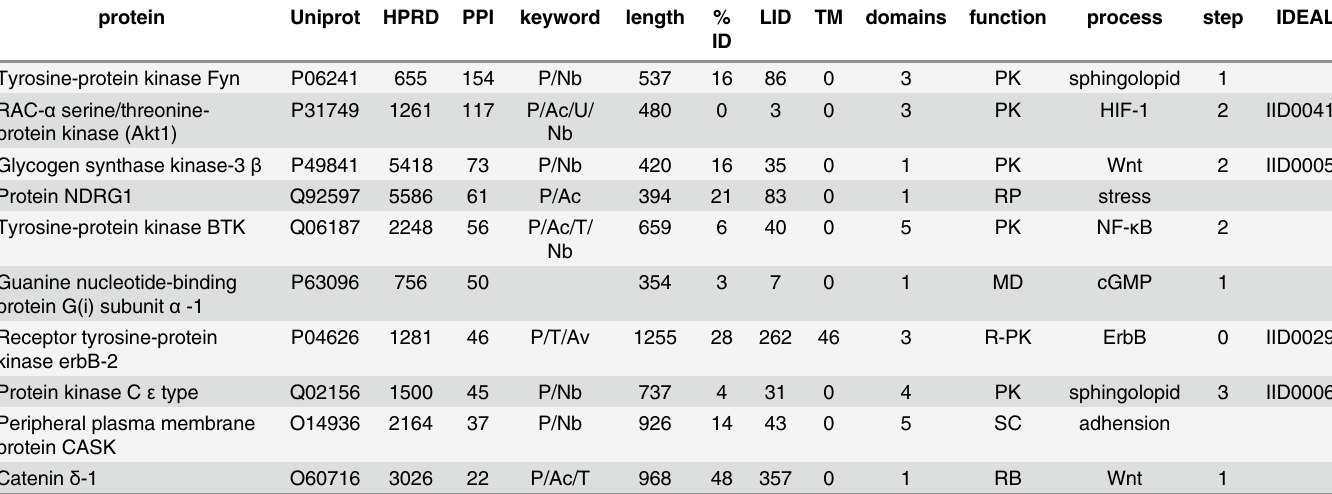
LID TM domains function process step IDEAL ID